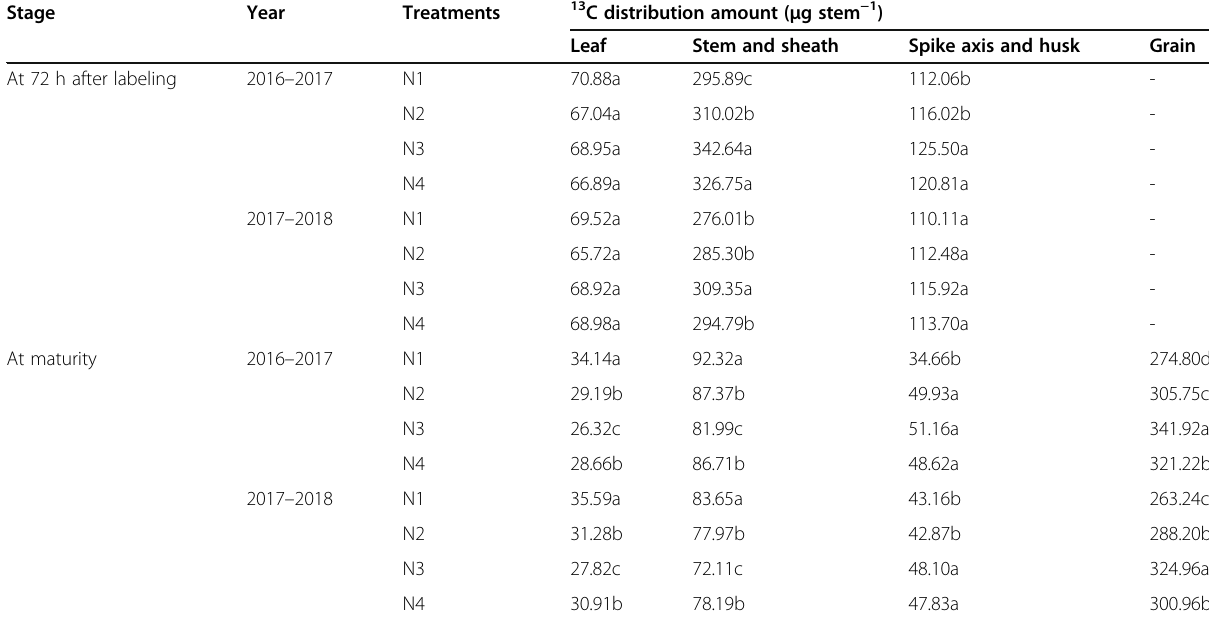
Table 2 Effects of four split nitrogen fertilizer treatments on 13 C distribution amount in different organs at 72 h after labeling and maturity in wheat plants. Different letters in each column represent significant differences in each tissue among four treatments at each sampling date according to LSD at 5% level Stage At 72 h after labeling